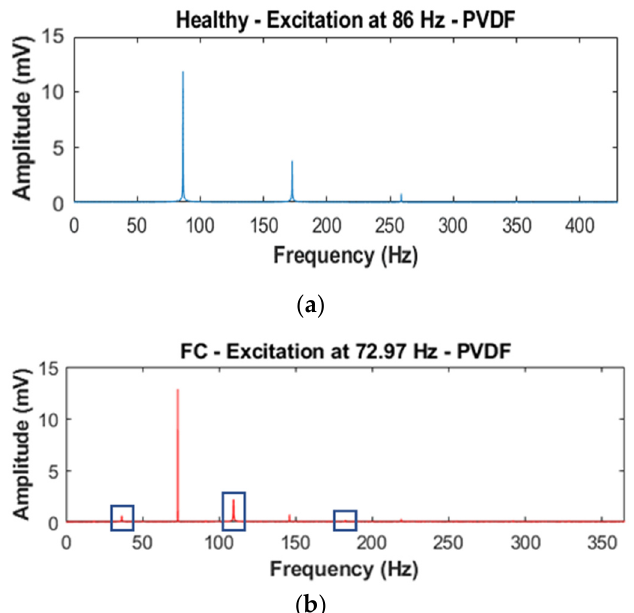
Figure 14. Amplitude vs frequency curves for ( a ) healthy and ( b ) FC plates for the SFE method. To visualize the influence of damage, a histogram showing the R peak for each ratio of fundamental frequency excitation was created. The sub-harmonics 0.3/0.5 and the super-harmonics 1.5/2.5 were used. In order to visualize the ratio of the four plates, R peak (%) is presented in a logarithmic scale (Figure 15).